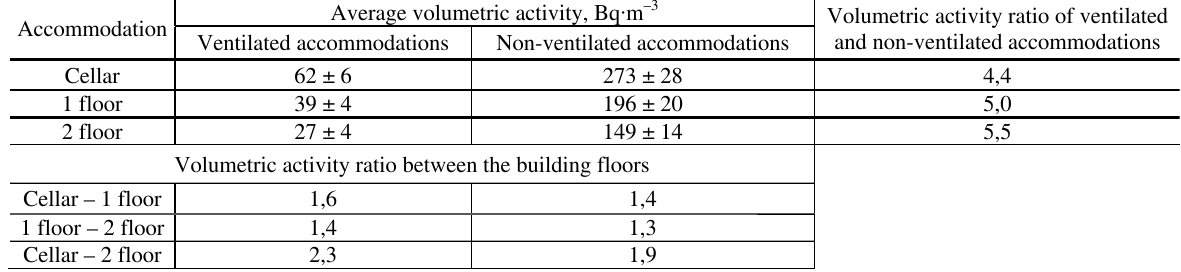
Table 1. Radon progeny volumetric activity in individual